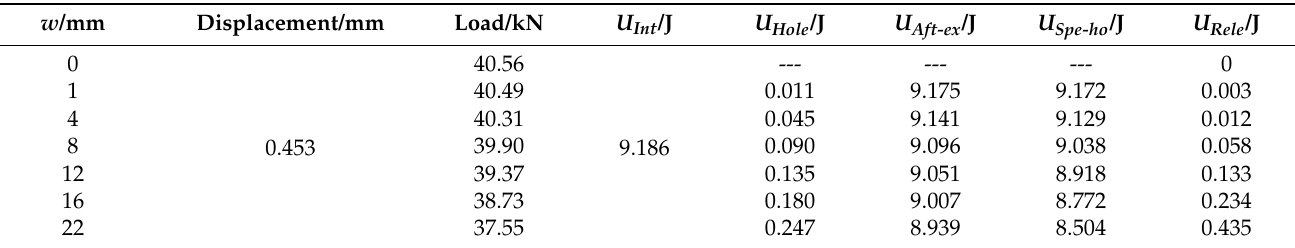
Figure 10. The width of hole w increases from 1 mm to 22 mm.